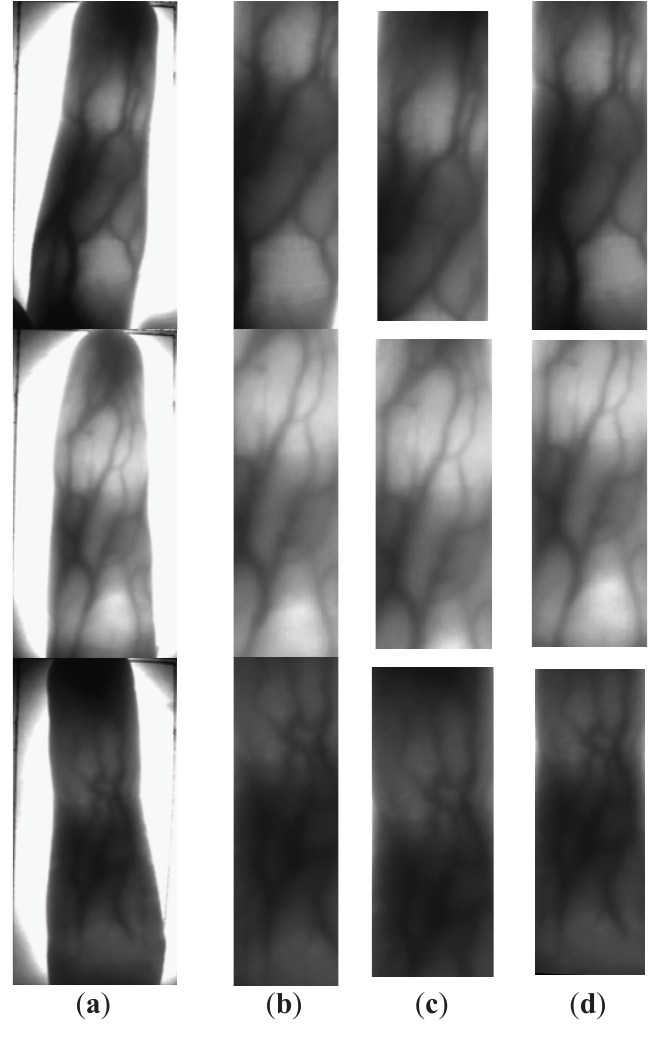
Figure 10. Some typical image samples and their ROIs. ( a ) Some typical finger vein